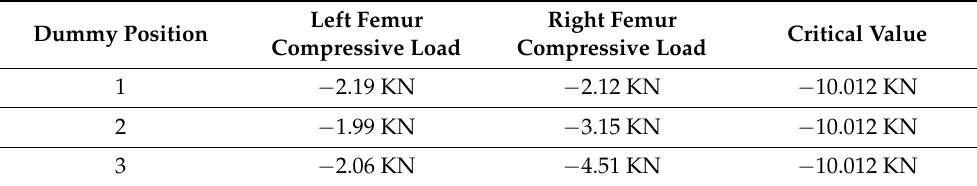
Table 13. Summary of Test 3: Femurs’ maximum compressive force values.